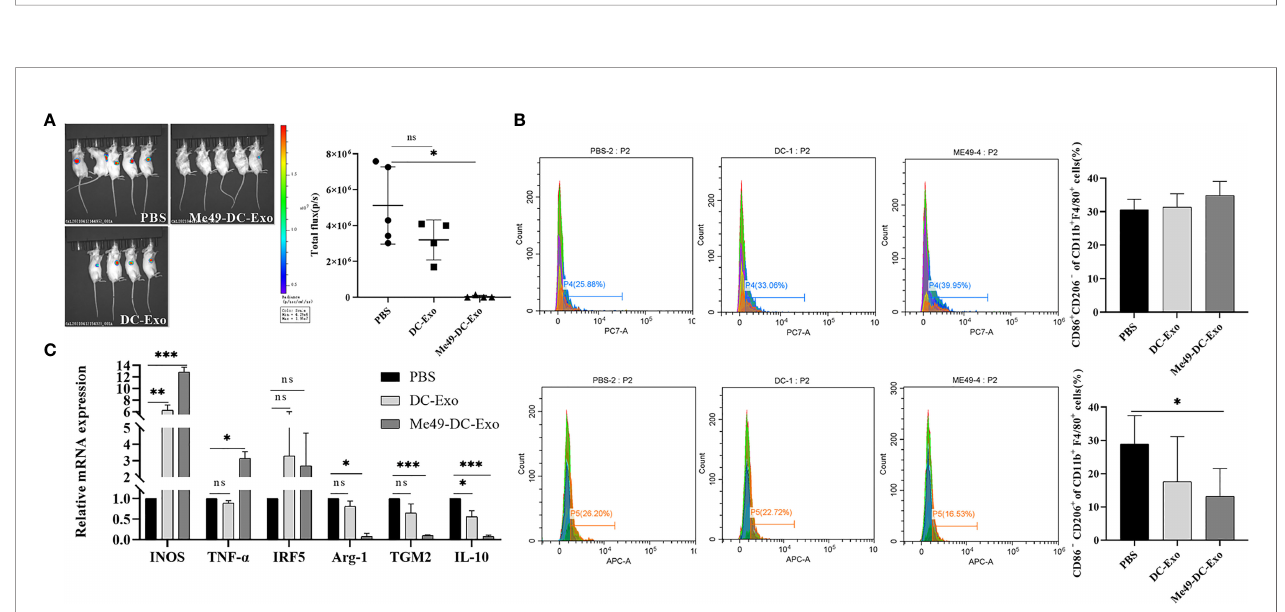
FIGURE 2 | Me49-DC-Exo inhibited tumor growth in mouse and regulated macrophage polarization. (A) On day 4 after treatment, the IVIS imager detected bioluminescence images in tumors of mouse and quanti fi ed the bioluminescence signal intensity of each tumor in mouse. (B) Flow cytometry was used to label CD86 + or CD206 + , and CD45 + CD11b + F4/80 + macrophages in blood of mice injected with DC-Exo and Me49-DC-Exo were stained to detect the percentage of CD86 + CD206 − M1 macrophages and CD86 − CD206 + M2 macrophages. (C) mRNA levels of M1 macrophage speci fi c genes (INOS, TNF- a , and IRF5) and M2 macrophage speci fi c genes (TGM2, Arg-1 and IL10) in blood of tumor-bearing mice injected intratumorally with PBS, DC-Exo and Me49-DC-Exo were detected by qRT-PCR. The data were expressed as mean ± standard deviation, and the independent sample t-test was used to compare the statistical differences between two groups. ns ( p ≥ 0.05), * p < 0.05, ** p < 0.01, *** p < 0.001.